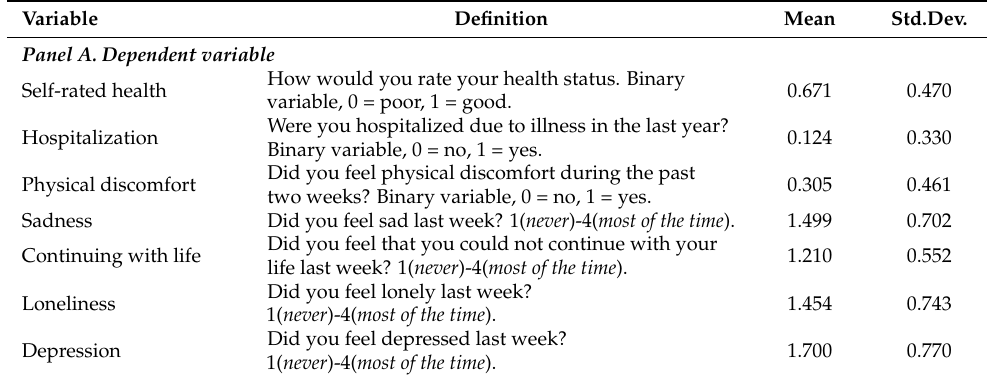
Table 1. Summary statistics of key